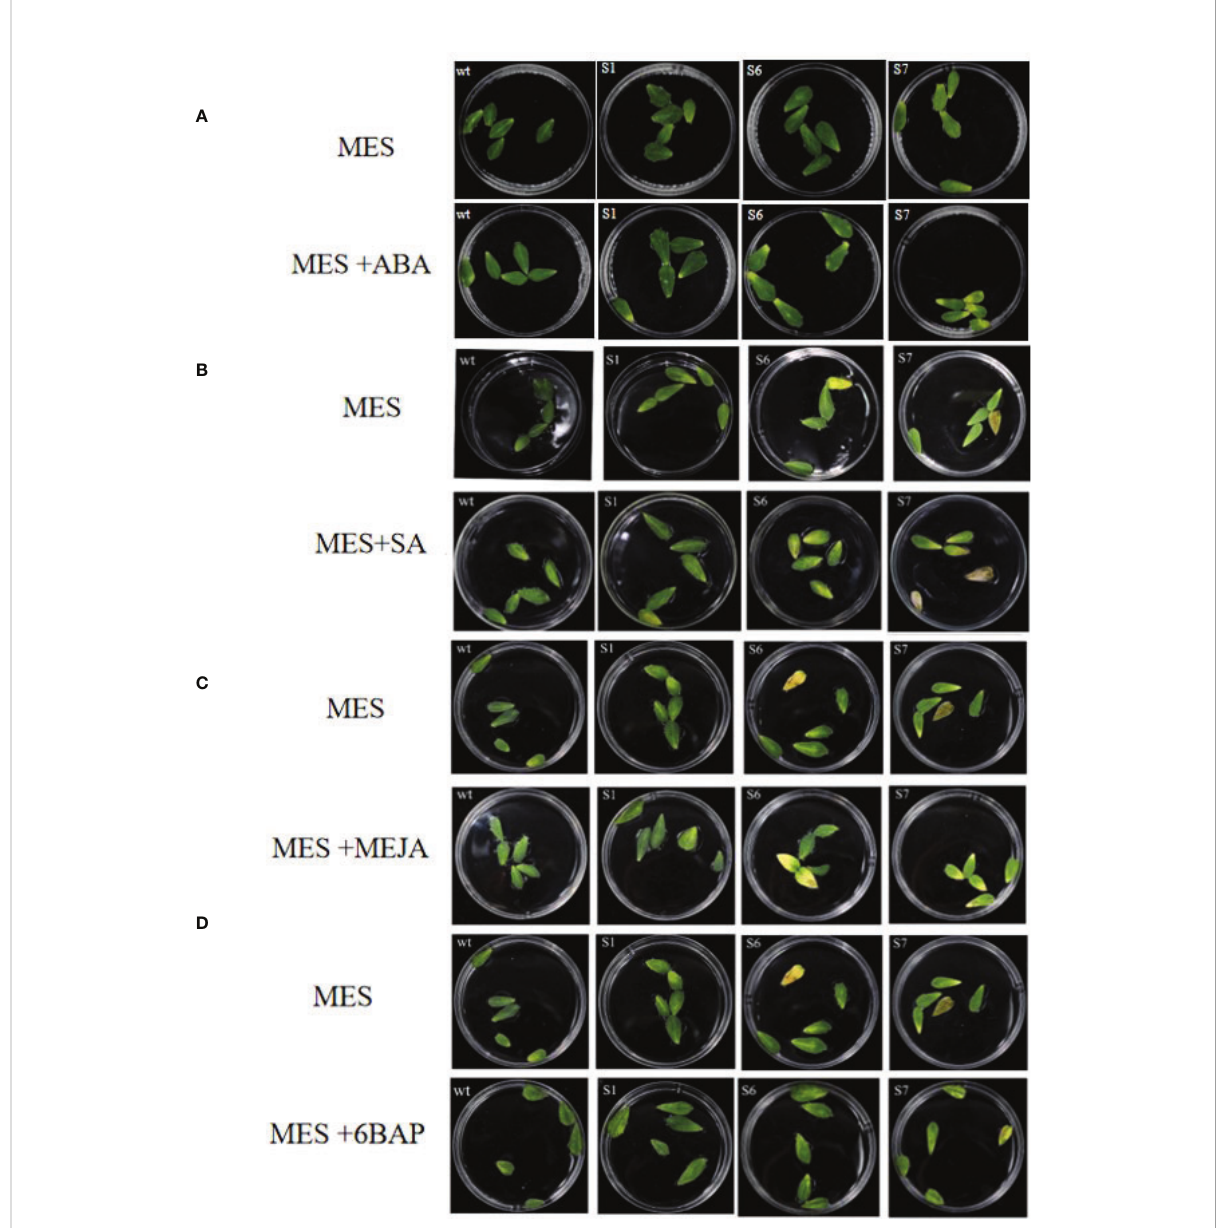
FIGURE 6 Detached leaves in MES with different hormones. Transgenic and WT detached leaves with or without ABA treatments for 5 days (A) . Transgenic and WT detached leaves with or without SA treatments for 8 days (B) . Transgenic and WT detached leaves with or without MeJA treatments for 12 days (C) . Transgenic and WT detached leaves with or without 6BAP treatments for 12 days (D)